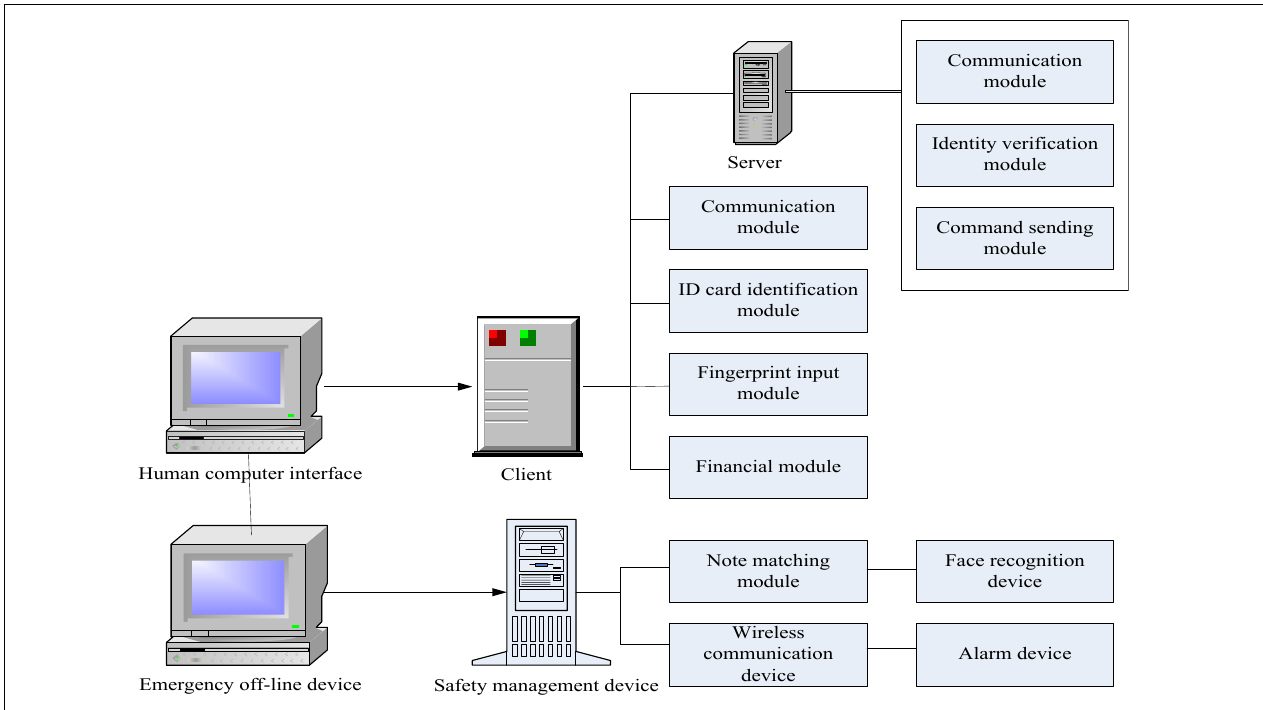
FIGURE 1 | Integration framework of financial self-service